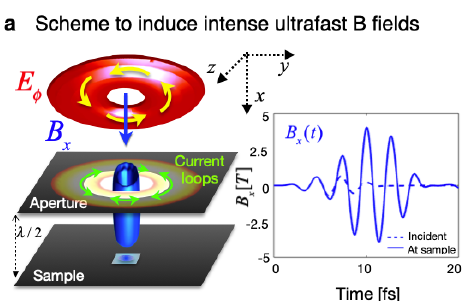
Fig. 2. Enhanced ultrafast magnetic field (blue) at a metal sample irradiated by an infrared femtosecond azimuthally polarized beam